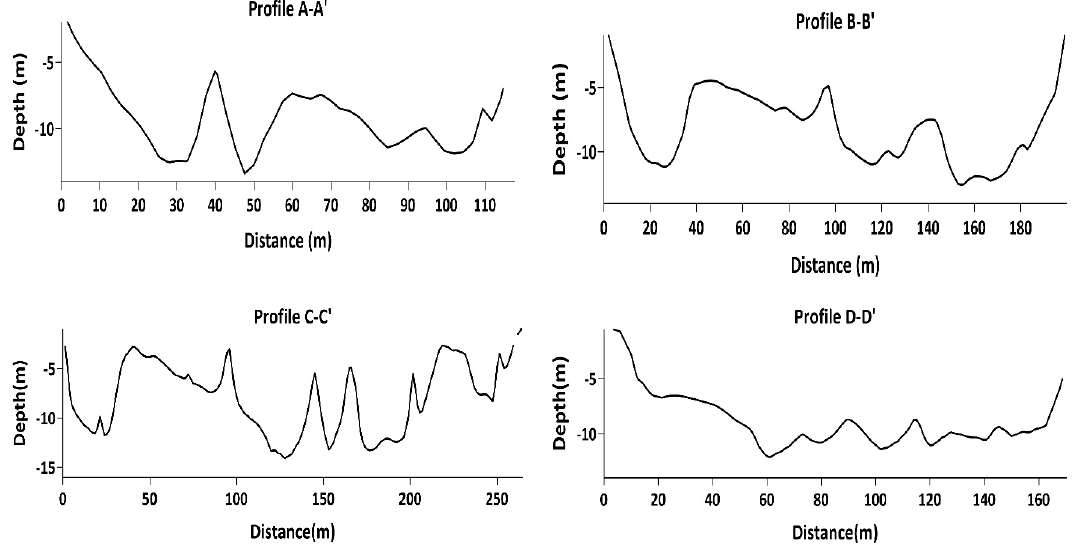
Figure 7. Depth profiles of Rungiri quarry reservoir.